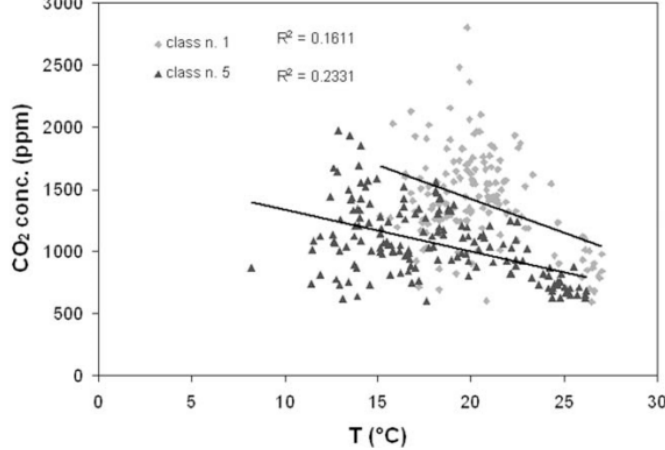
Figure 27. Correlation between temperature and CO 2 concentration [12].